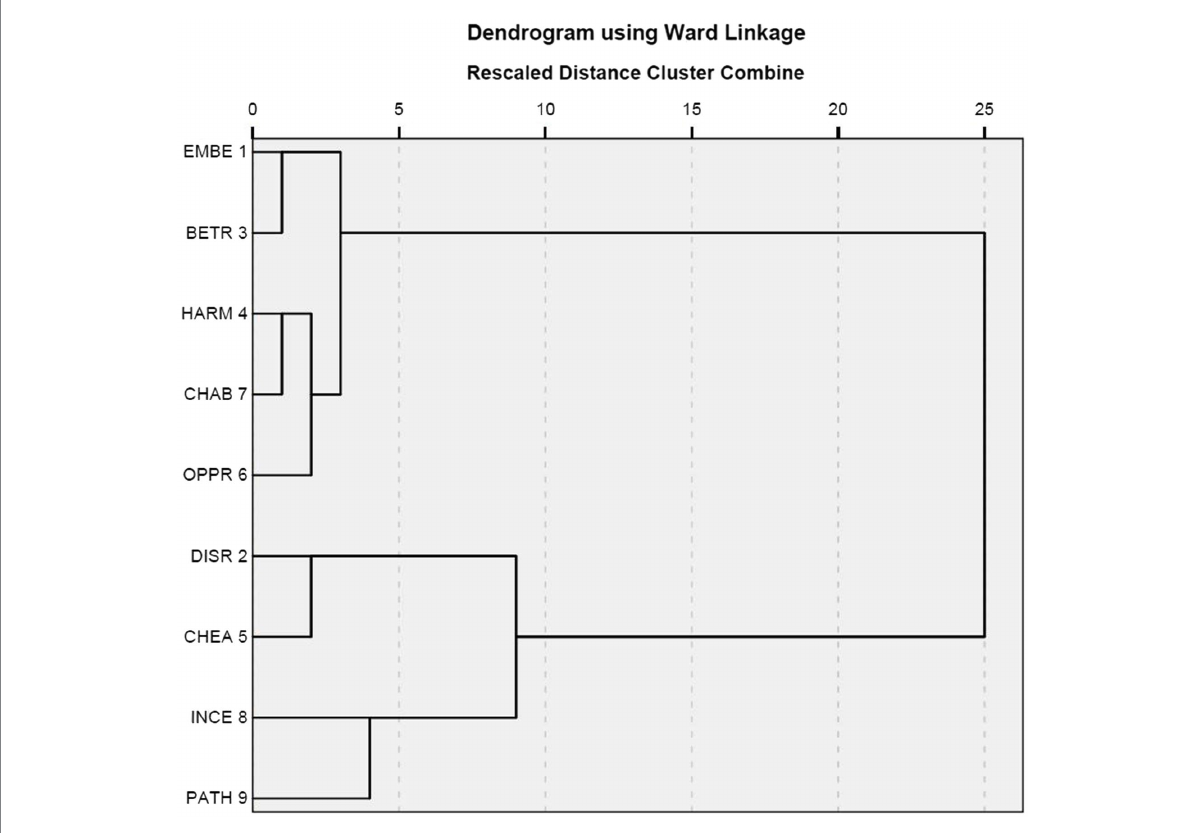
FIGURE 4 Cluster analysis on all